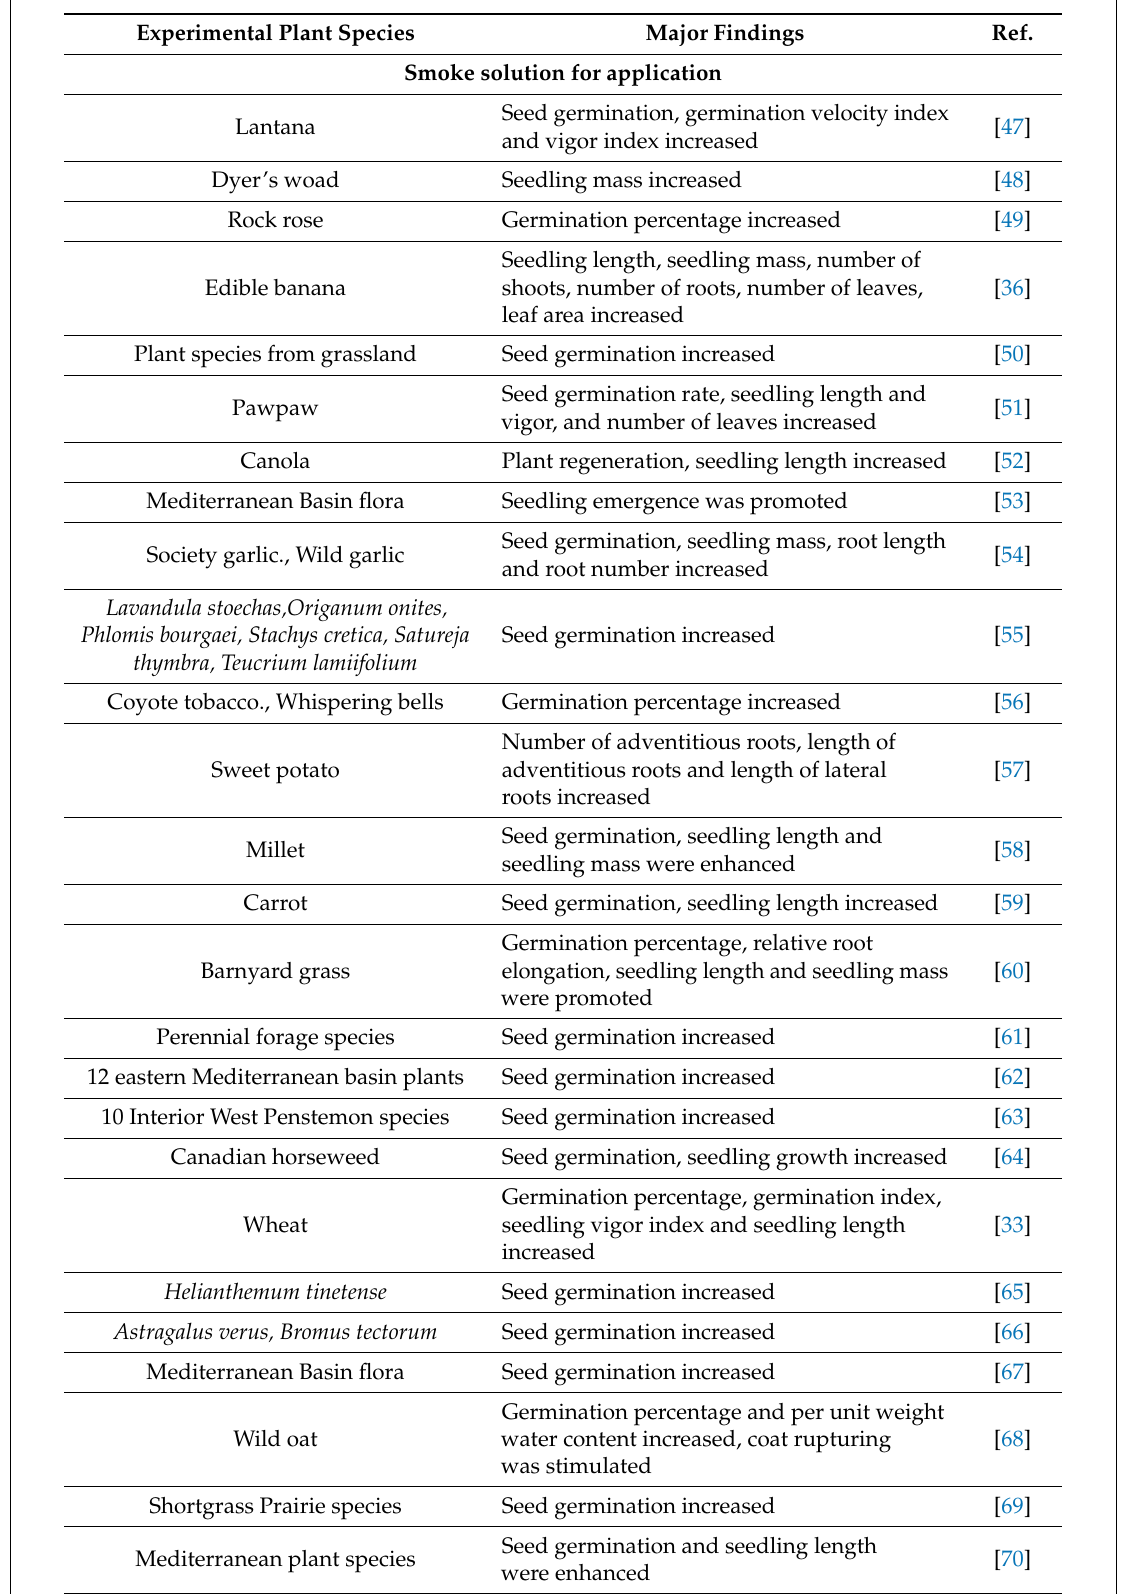
Table 2. E ff ect of plant-derived smoke on seed germination and plant-growth responses of various plant